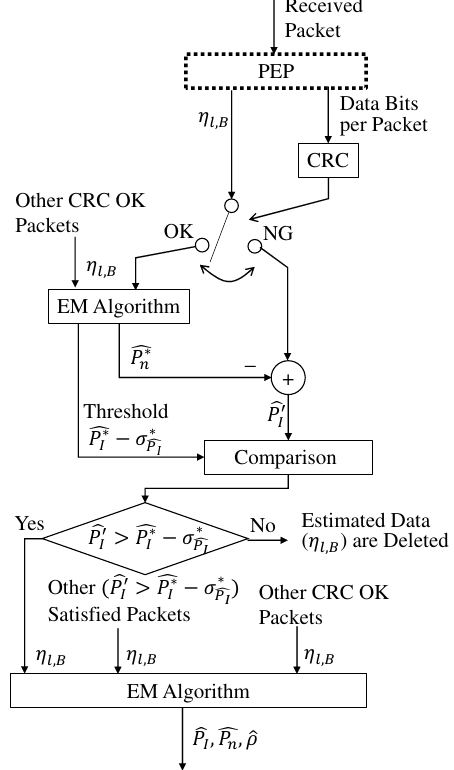
Figure 5. Flow for packet selection in proposed estimation